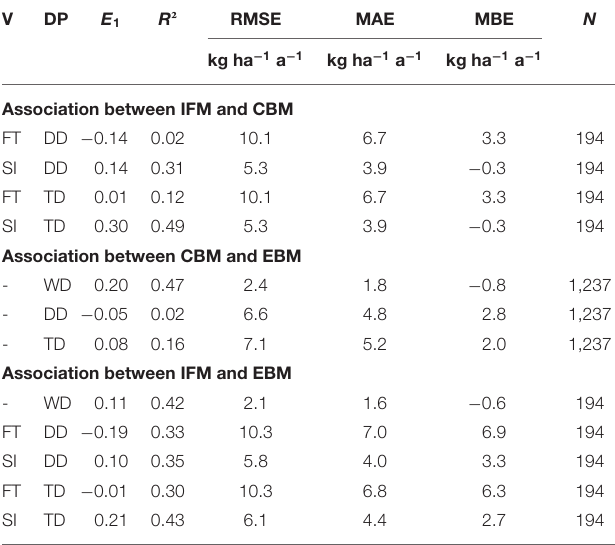
TABLE 6 | Indicators for the association between canopy budget (CBM), inferential (IFM) and emission based method